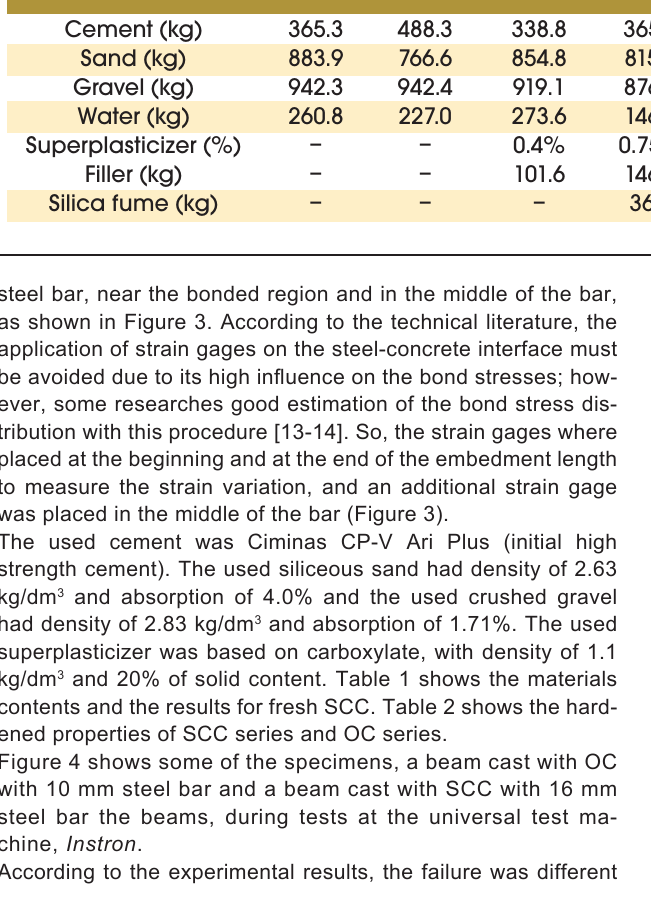
Figure 3 – Steel bar instrumentation